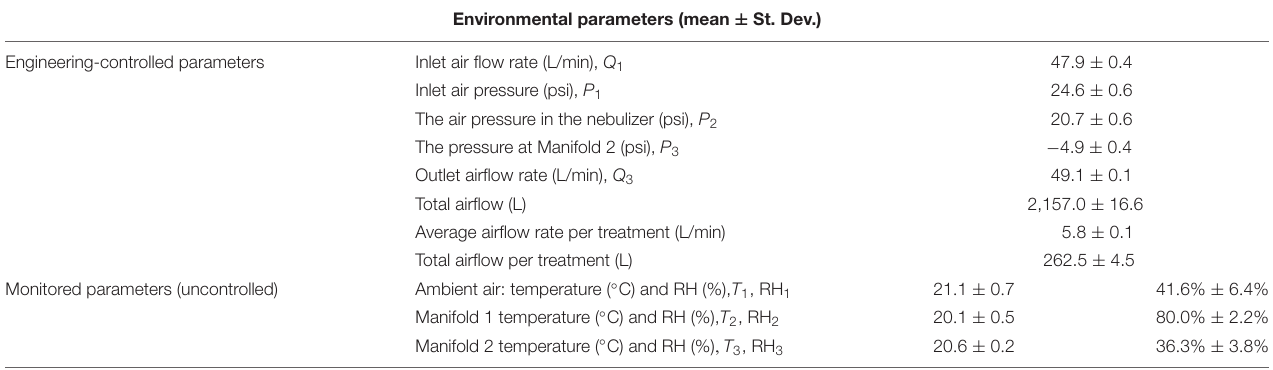
TABLE 4 | Environmental data for all experimental trials on aerosolization and collection of PRRSV. Environmental parameters (mean ± St. Dev.)